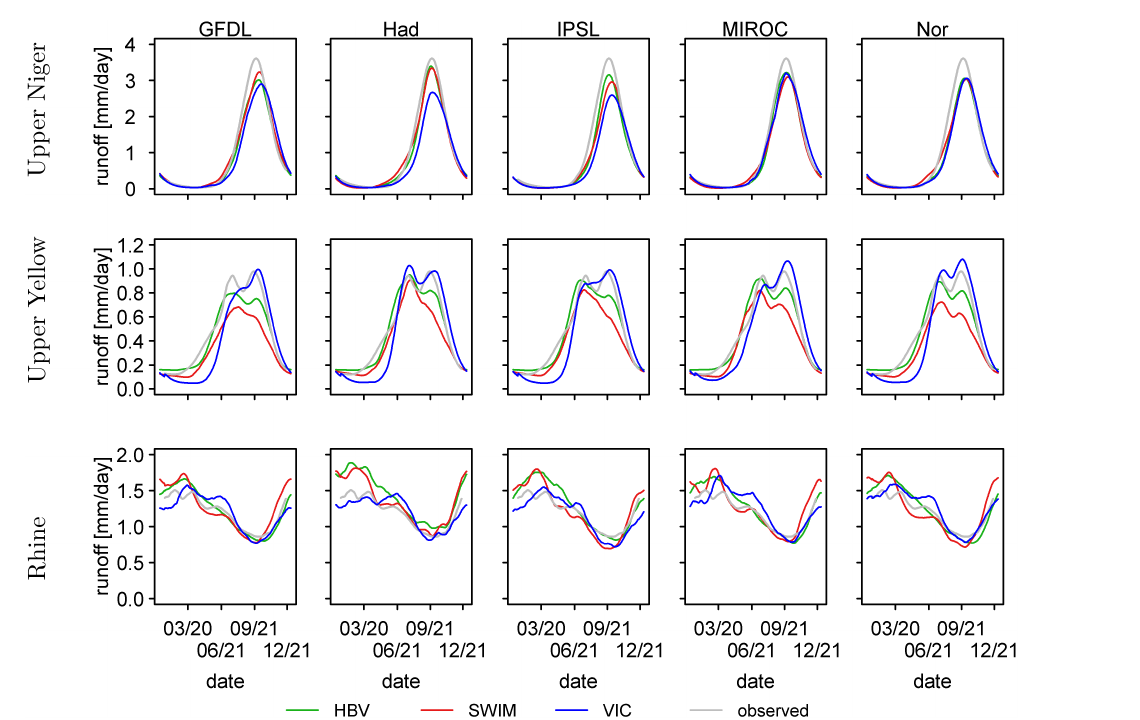
Figure 5. Comparison of the long-term average seasonal observed discharge in 1961–1990 with discharge driven by five climate models and three hydrological models for the same